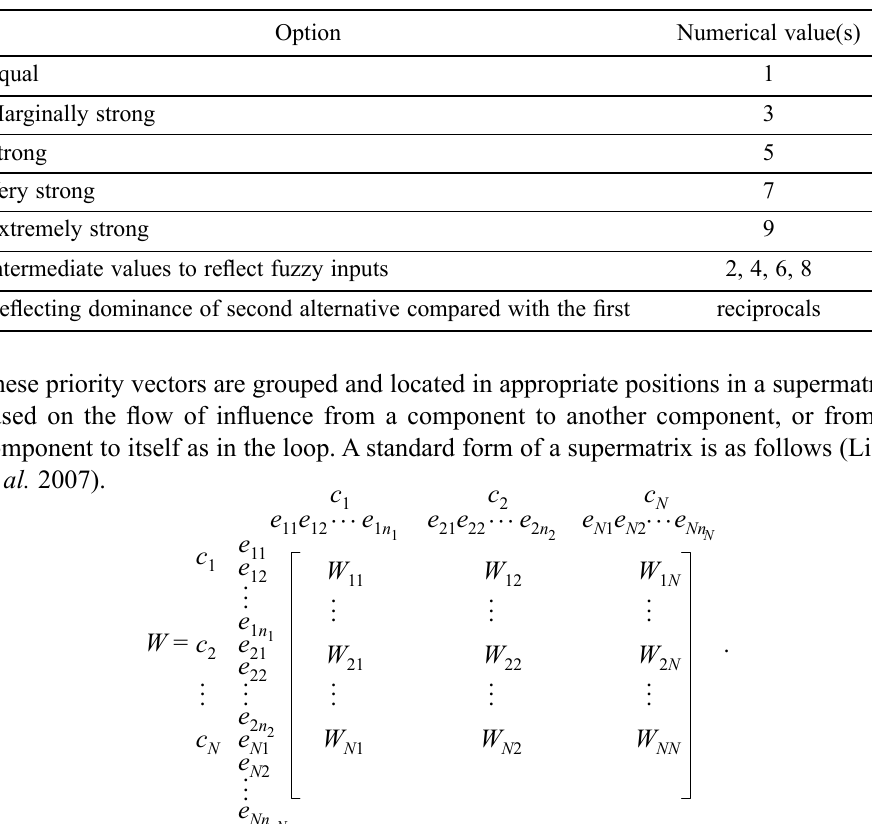
Table 1. Pair-wise comparison scale (Saaty